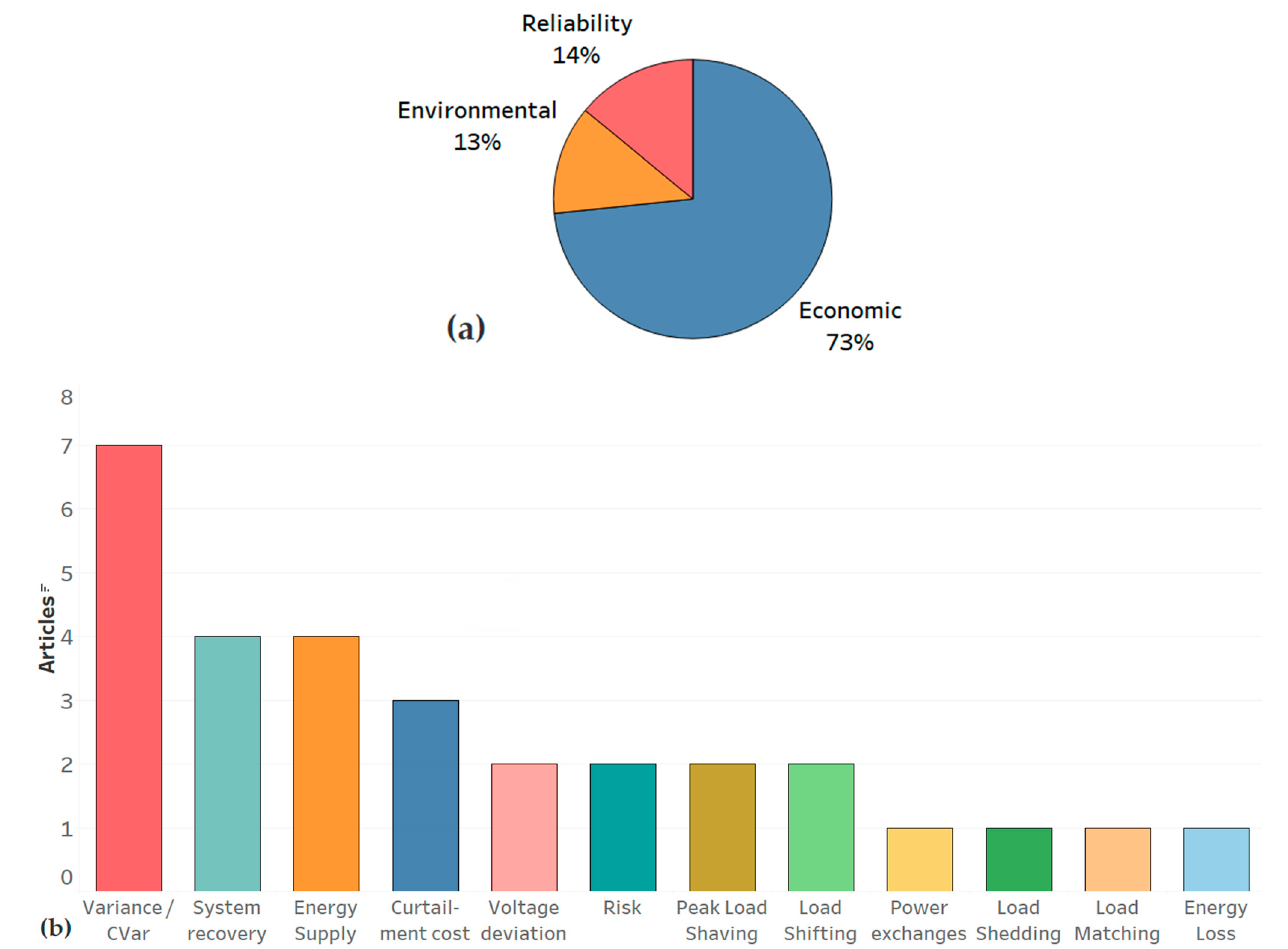
Figure 7. ( a ) Share of each objective function type. ( b ) Number of articles that use a specific reliability objective function. Note: Each article may consider more than one objective function. Self-elabora- tion.